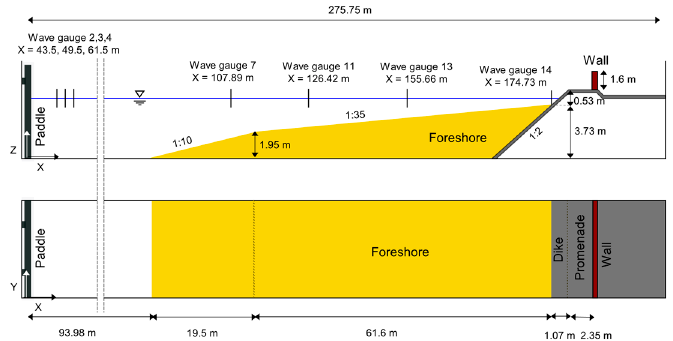
Figure 1. Overview of the geometrical parameters of the wave flume and WALOWA model set-up, with indicated wave gauge locations. Reprinted with permission from [29].